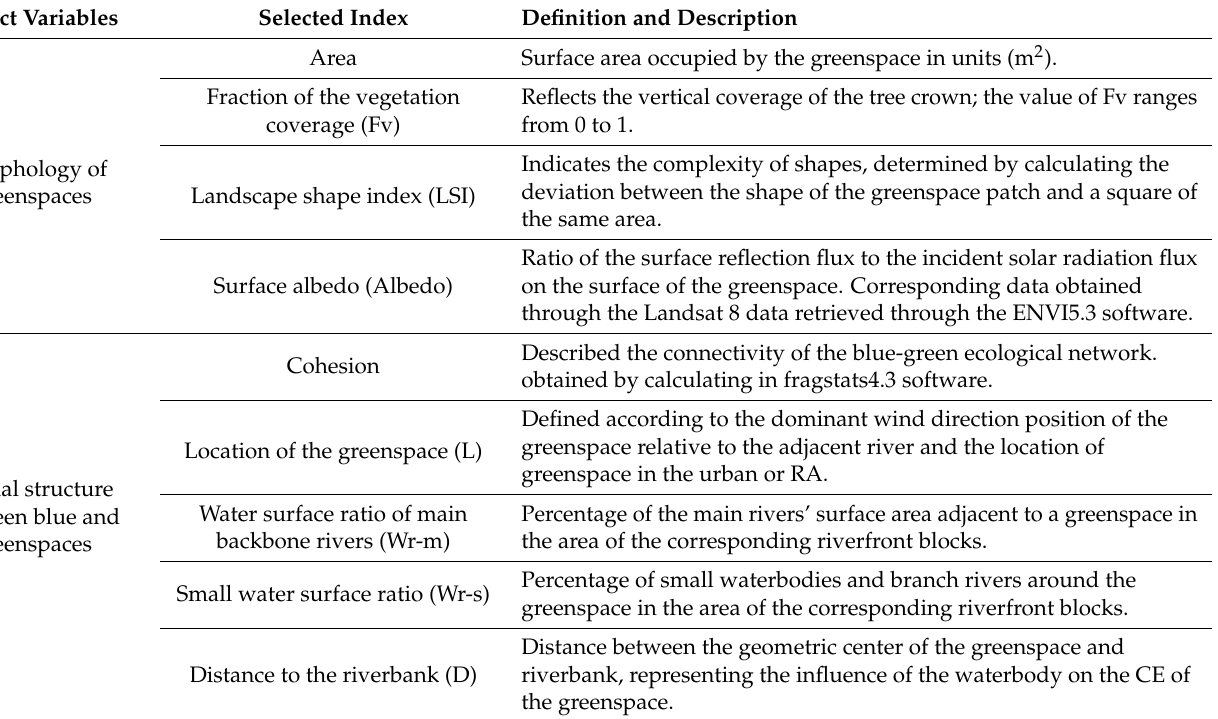
Table 2. Multidimensional spatial variables to describe riverfront greenspaces morphology based on the